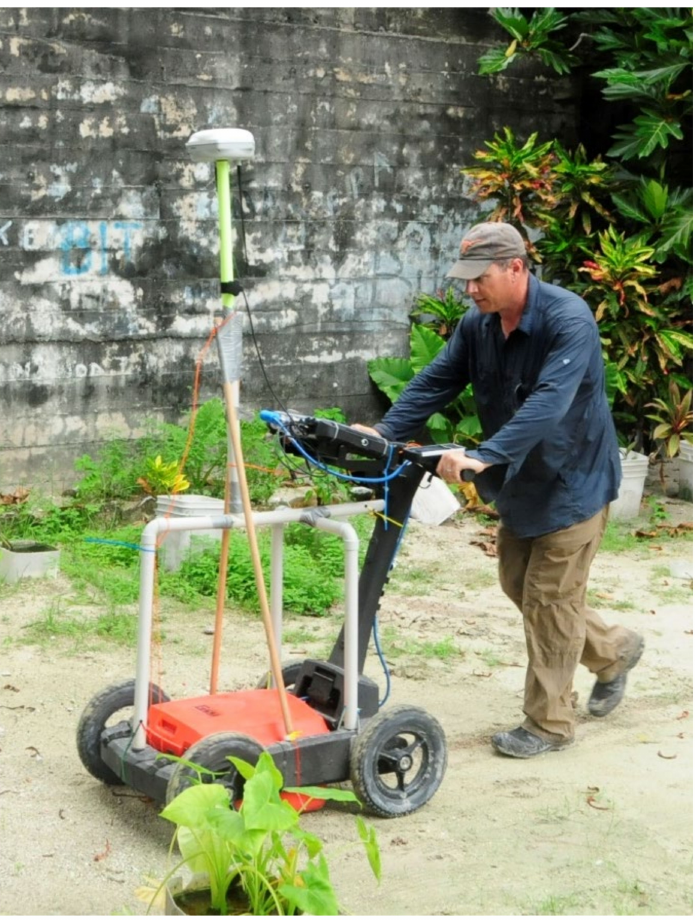
Figure 1. Typical GPR unit in use. GSSI SIR 4000 GPR with a 400 MHz